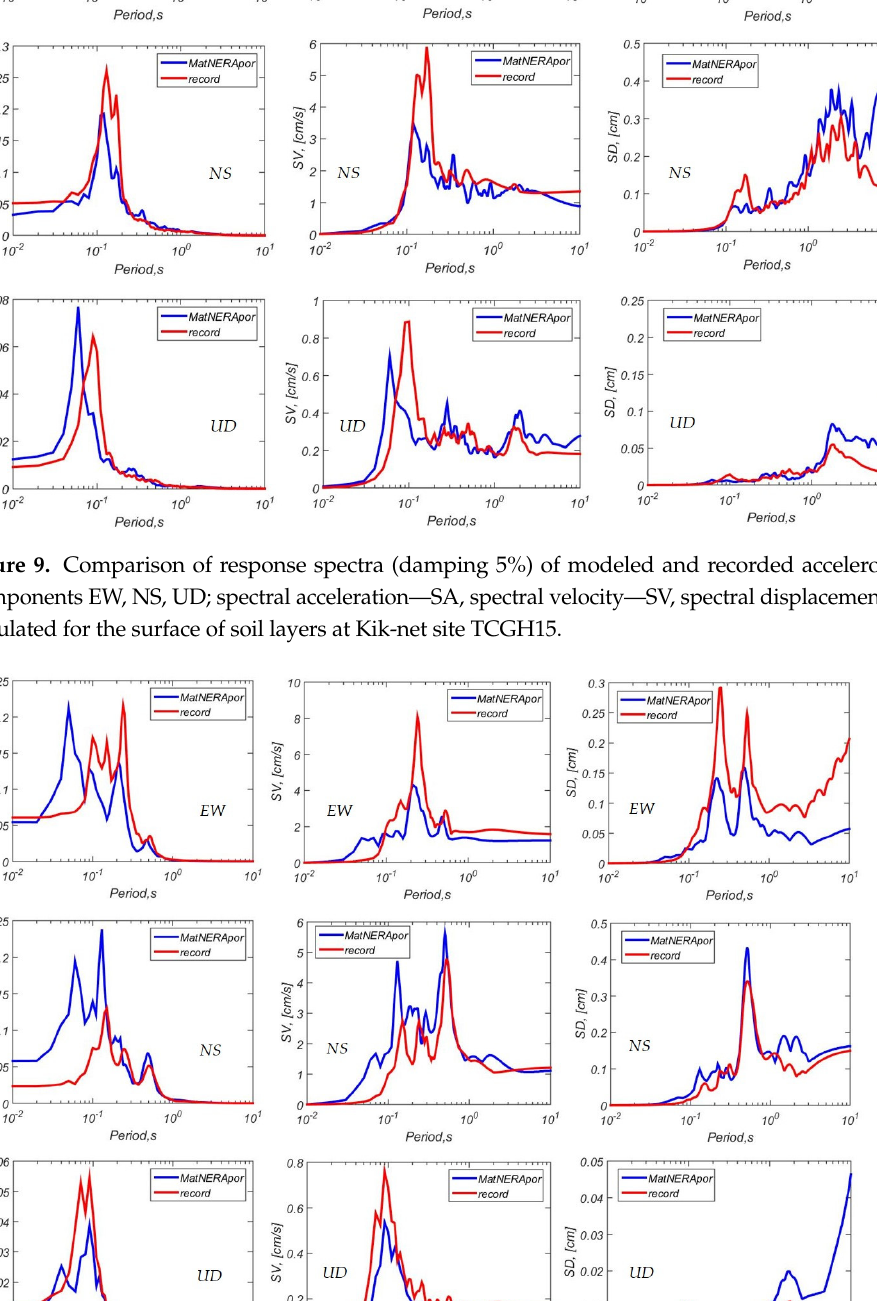
Figure 10. Comparison of response spectra (damping 5%) of modeled and recorded accelerograms (components EW, NS, UD; spectral acceleration—SA, spectral velocity—SV, spectral displacement—SD) calculated for the surface of soil layers at Kik-net site KSRH10.